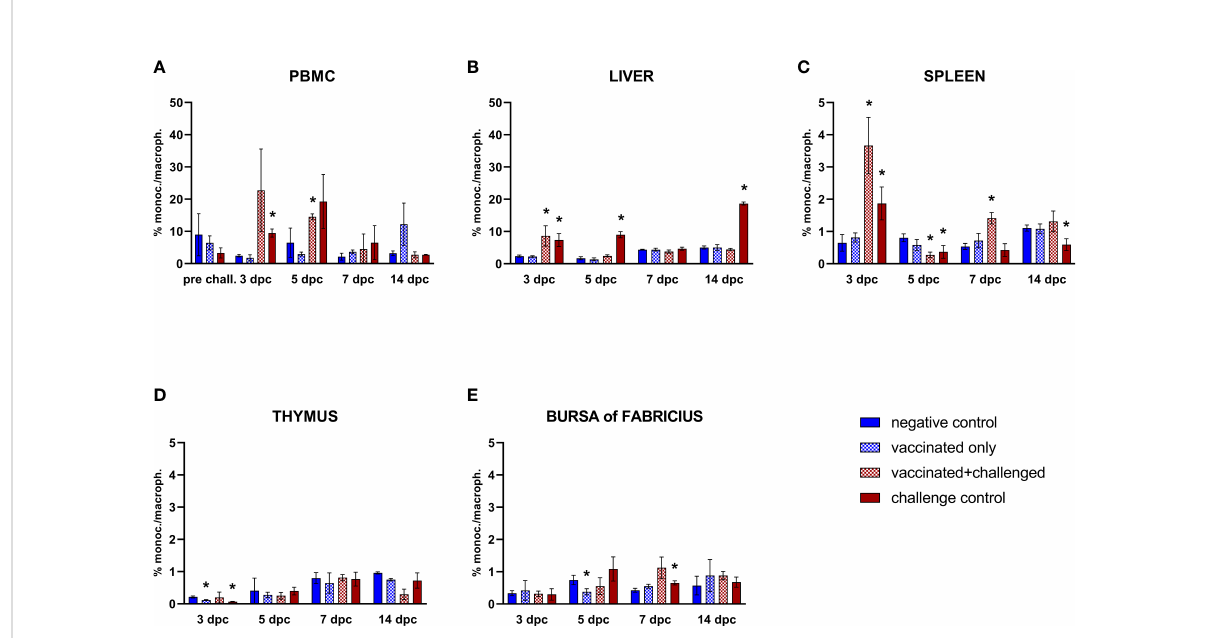
FIGURE 4 Relative number of monocytes/macrophages within total CD45 + cells measured via FCM for each experimental group throughout the study in PBMC (A) , liver (B) , spleen (C) , thymus (D) , and bursa of Fabricius (E) . Data for the two vaccinated groups (vaccinated only and vaccinated+challenged) are merged to determine values in PBMCs pre-challenge. Asterisks represent signi fi cant difference compared to the negative control at each time point ( p ≤